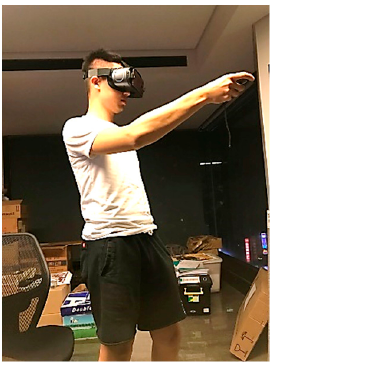
Figure 4. Experimental design. ( a ) General navigation system; ( b ) VR navigation system.